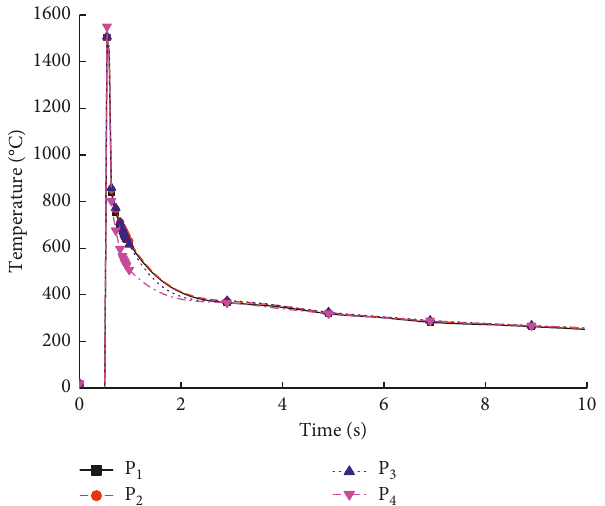
Figure 7: The temperature evolution at the trace points (1 st welding condition).